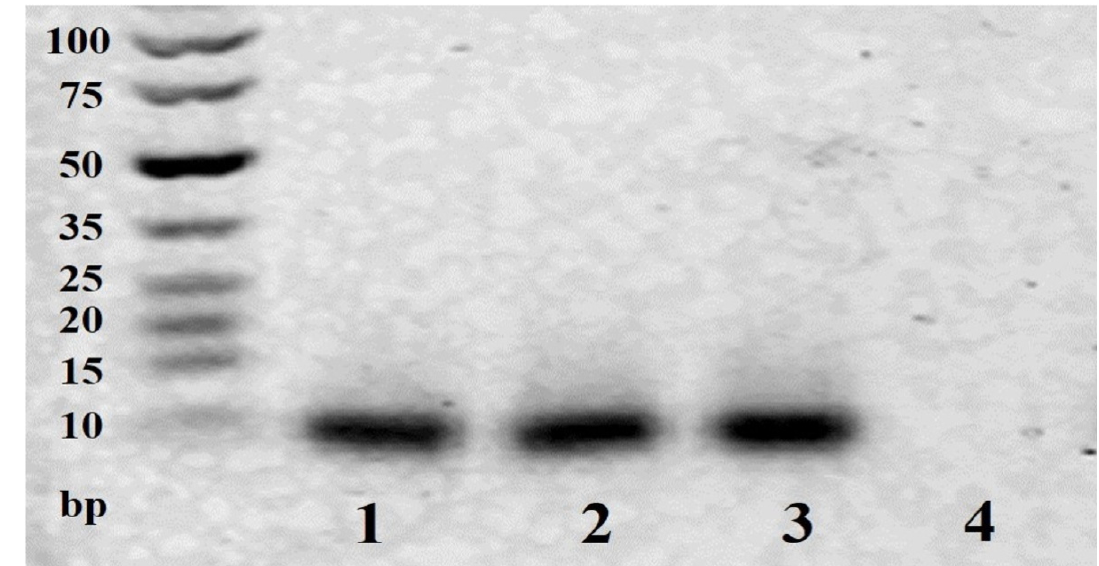
Figure 2. Agarose gel of MB155 cleavage. (Lane 1: MB155; Lane 2: MB155 + H 2 O 2 ; Lane 3: MB155 + Cu 2+ ; Lane 4: MB155 + H 2 O 2 + Cu 2+ ). Concentration (MB155) = 1 µ M. Concentration (H 2 O 2 and Cu 2+ ) = 1 mM.